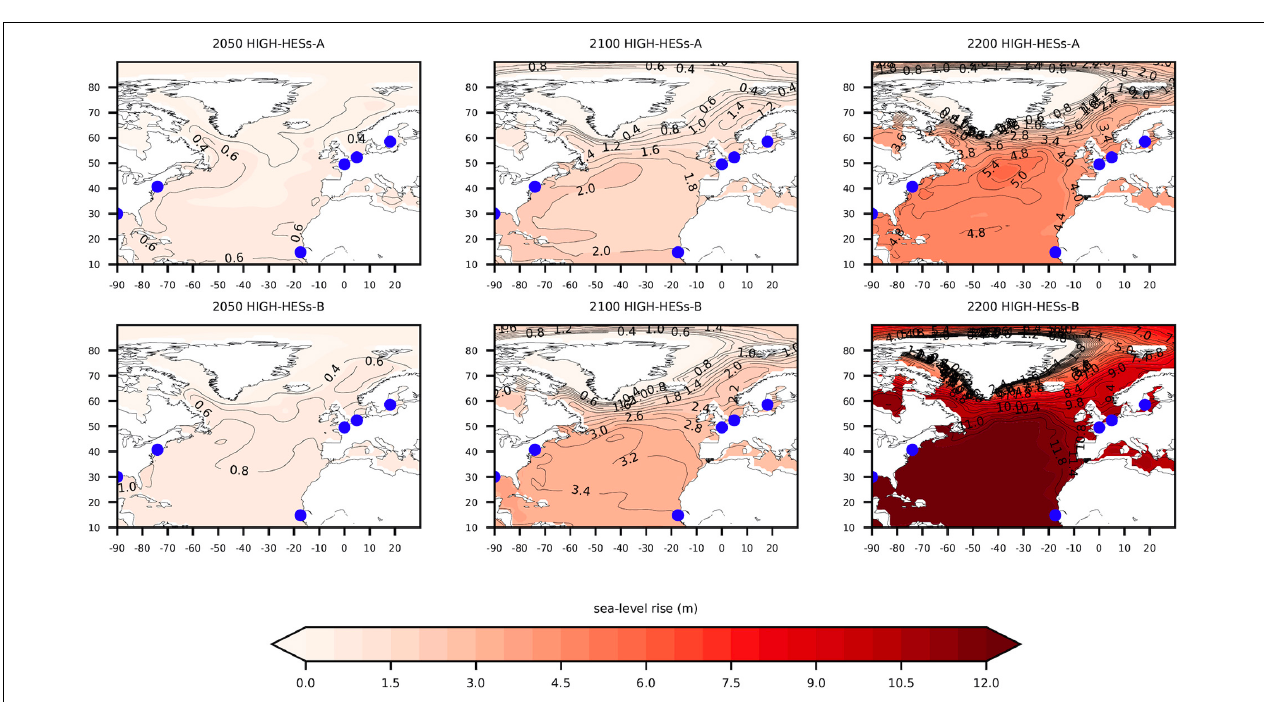
FIGURE 4 | Regional HESs for (first row) HESs-A and (second row) HESs-B in the northern Atlantic. Colors and contours display SLR (m) by (left) 2050, (middle) 2100, and (right) 2200 relative to 1986–2005. Blue circles represent the selected sites (refer to Figure 1 for the names) discussing from regional to local HESs.